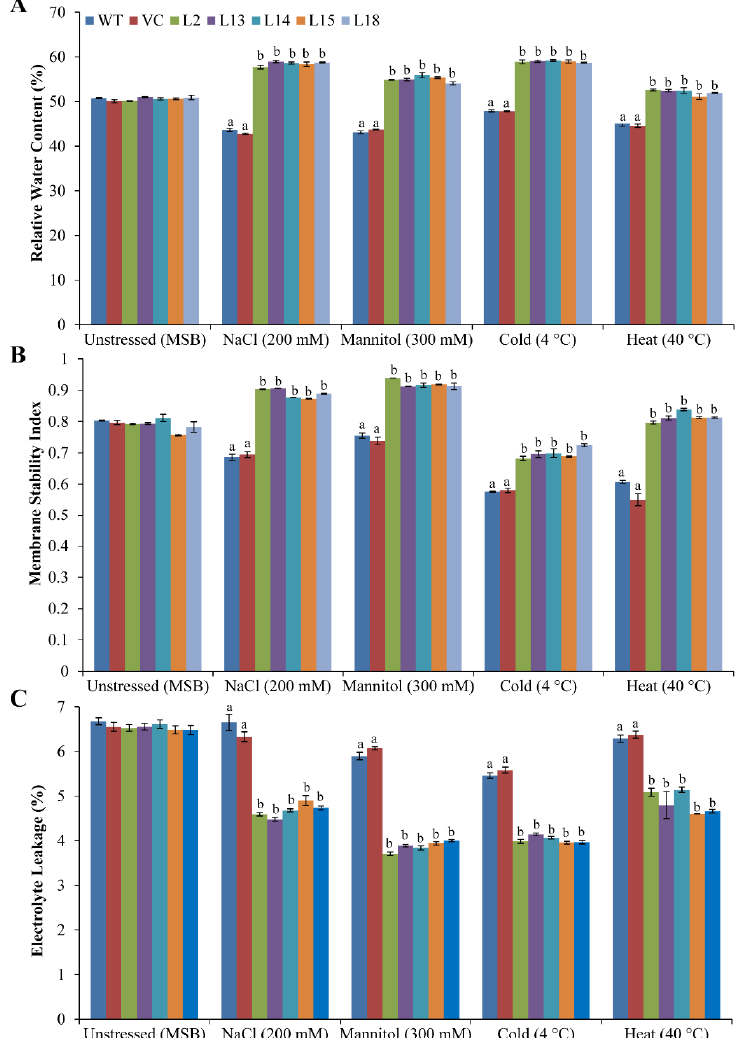
Figure 4. Analysis of plant physiology under diverse abiotic stress conditions. Comparative analyses of ( A ) relative water content (RWC), ( B ) membrane stability index (MSI), and ( C ) electrolyte leakage (EL) of transgenic lines (L2, L13, L14, L15, and L18) and control plants (WT and CV) grown under unstressed (MSB), salt (200 mM NaCl), osmotic (300 mM mannitol), cold (4 °C), and heat (40 °C) stress conditions. Data are shown as mean ± SE and different letters show significance at p < 0.05.